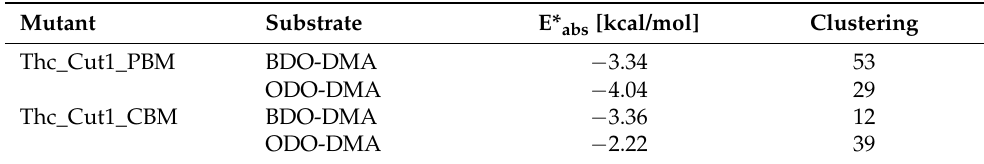
Table 4. AutoDock data relative to the docking free energies computed only for the poses correspond- ing to the lowest energy values.